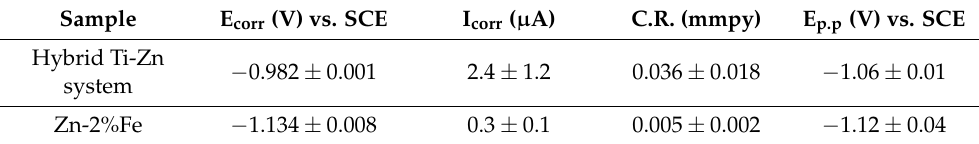
Table 3. Results obtained by Tafel extrapolation.